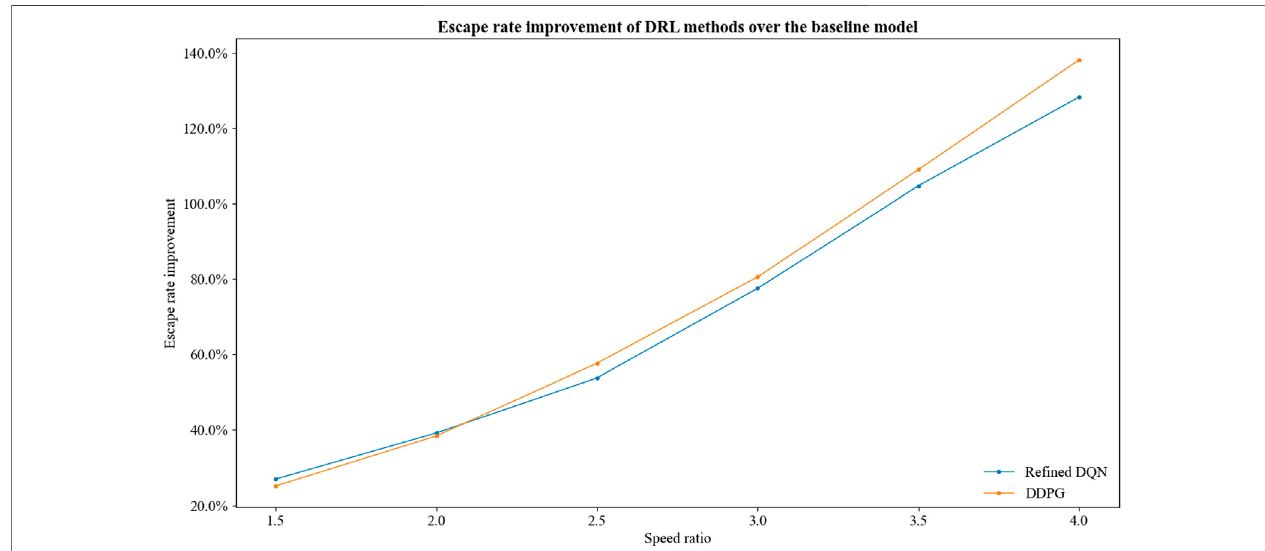
FIGURE 8 | Escape rate improvement of DRL methods over the baseline